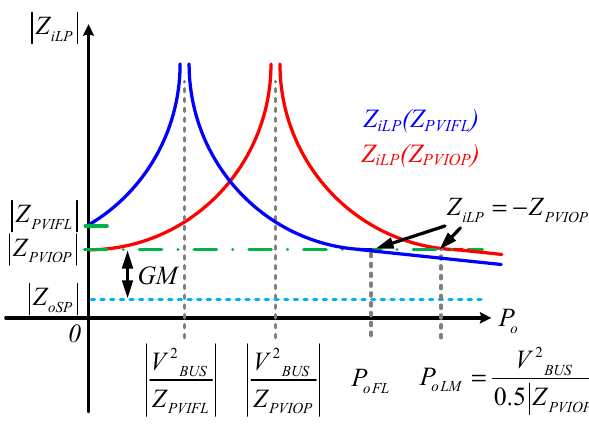
Figure 14. Curve of output load versus | Z iLP | under different Z PVI designs.